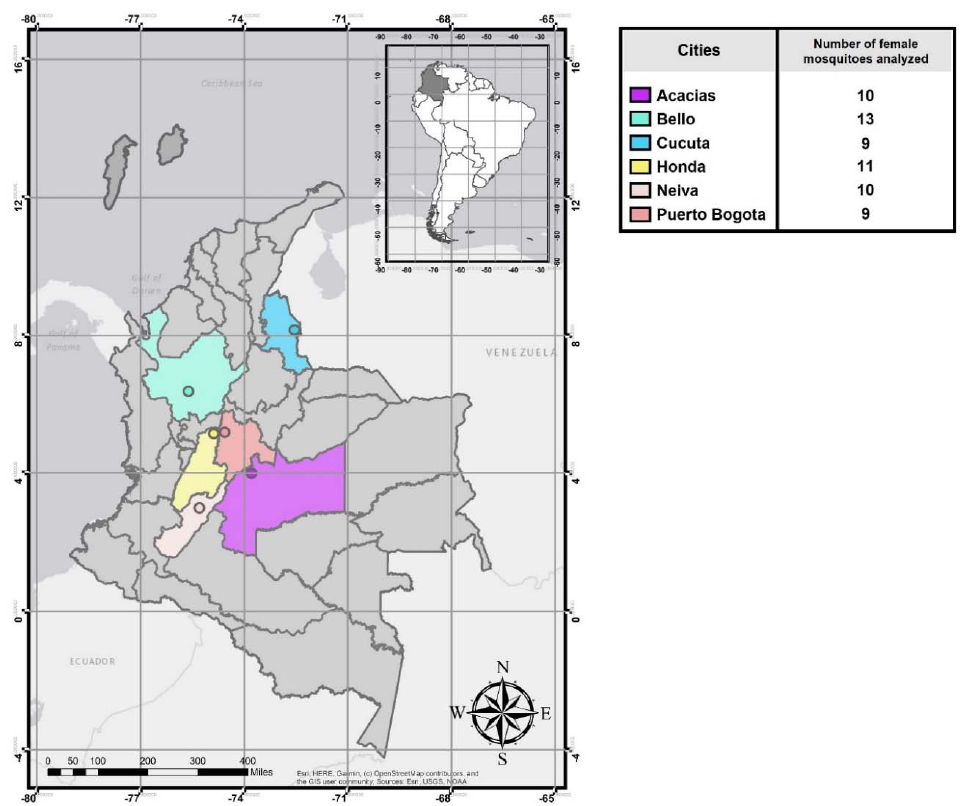
Figure 1. Map of Colombia showing cities where samples of Aedes aegypti mosquitoes were collected. The number of female mosquitoes analyzed in each city is indicated in the adjacent